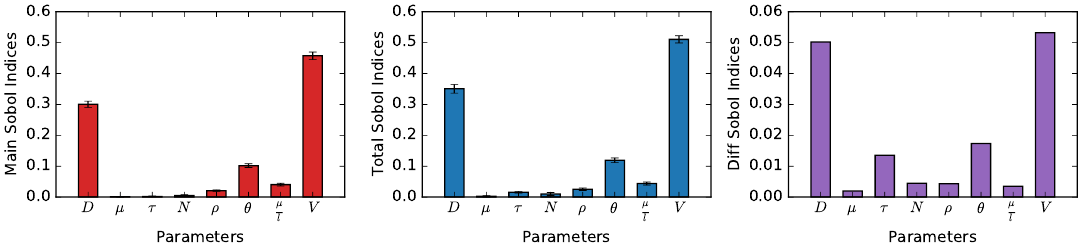
Figure 7. Sobol’ indices calculated from positive displaced volume of waves. The input parameters, as shown along the x axis, are: submergence depth, D ( m ) ; viscosity, µ ( Pas ) ; yield stress, τ ( Pa ) ; shear thinning exponent, N ; density, ρ ( kgm − 3 ) ; slope angle, θ ◦ ; boundary layer parameter, µ and volume, V ( m − 3 ) .